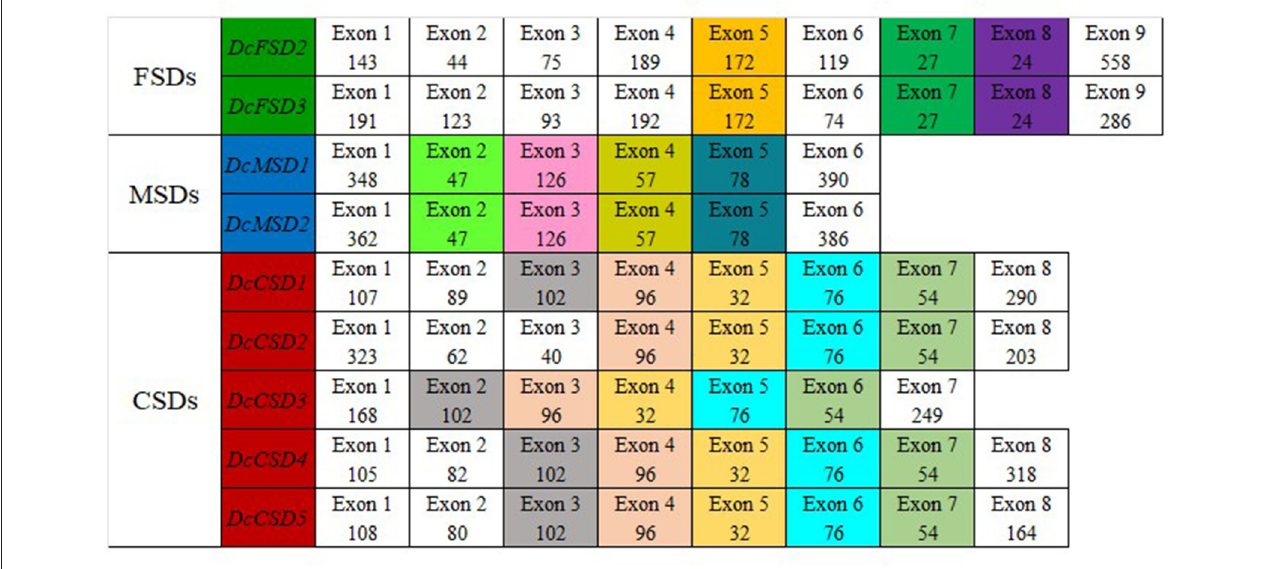
FIGURE 5 | Splice site analysis of 9 members of D. carota SOD gene family. Exons colored the same in each group conserved in length in that particular